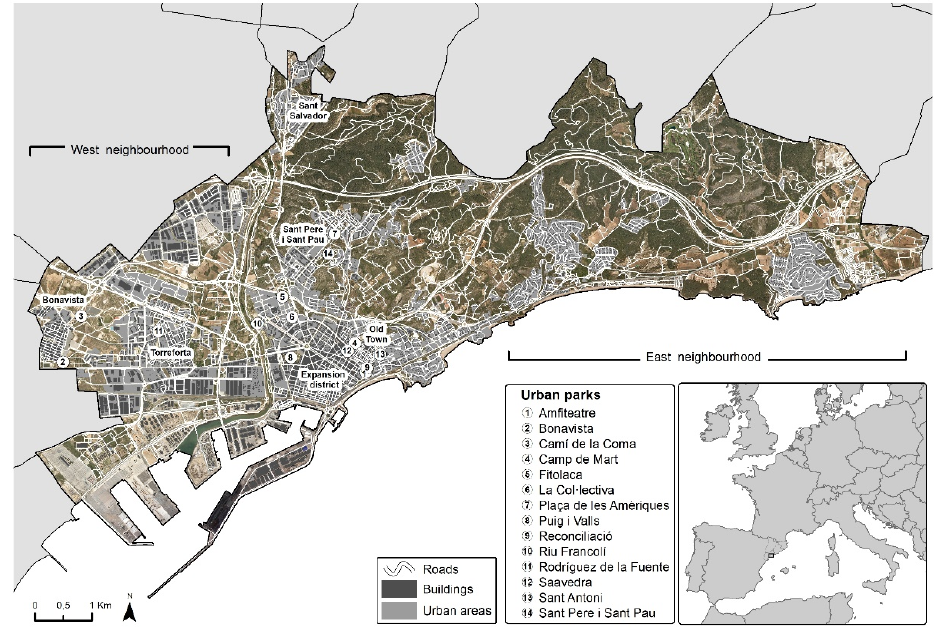
Figure 1. Location of the urban parks in Tarragona. Source: Own work. Orthophotomap base map 1:5000 of Cartographic and Geological Institute of Catalonia.